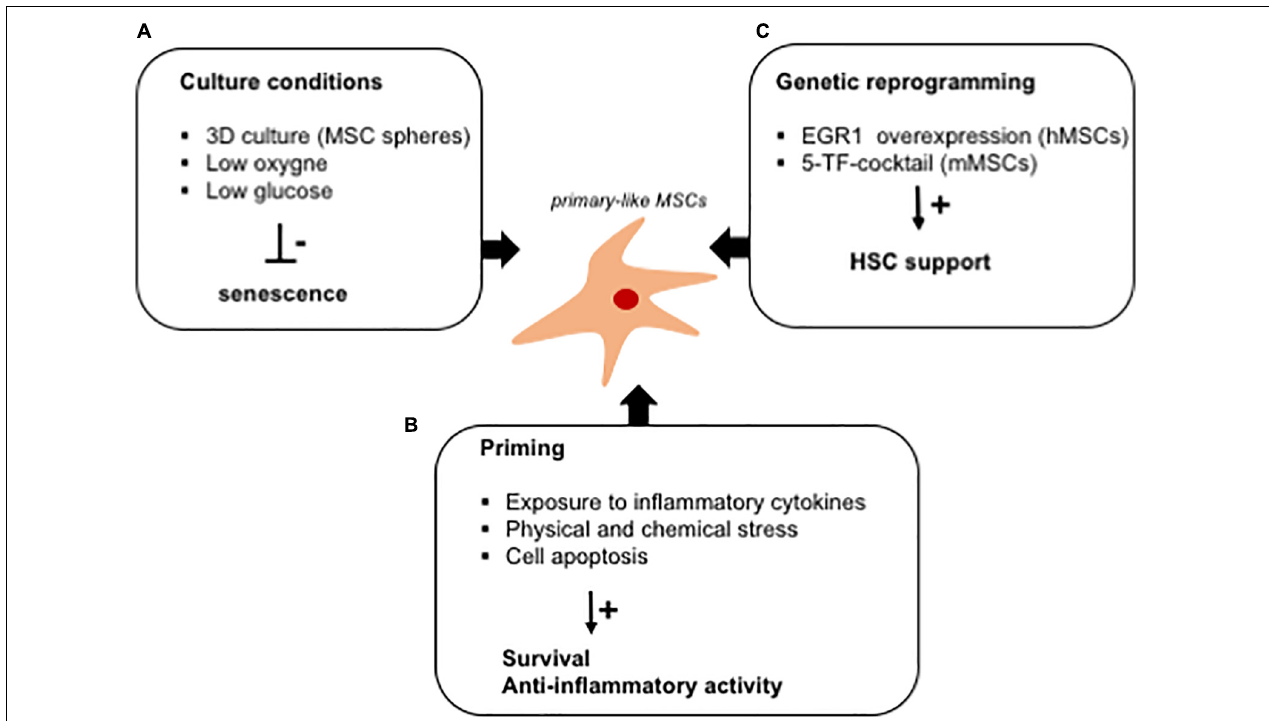
FIGURE 3 | In vitro strategies to fully exploit the hematopoietic supportive capacity of ex vivo expanded MSCs. Schematic representation of culture strategies aimed at improving the hematopoietic supportive capacity of MSCs, which is impaired upon ex vivo expansion. (A) Several strategies (mesensphere, low oxygen, and low glucose cultures) have been developed to avoid the activation of a senescence program altering the secretory phenotype of ex vivo expanded MSCs. (B) MSC priming with inflammatory cytokines has been demonstrated to increase the release of anti-inflammatory cytokines by MSCs. Similarly, exposure to culture stress increases the survival rate of MSCs when transplanted in vitro . The immunomodulatory activity of MSCs has been exploited for the treatment of GVHD by inducing cell apoptosis in ex vivo expanded cells. (C) Ex vivo reprogramming by the overexpression of specific transcription factors has been studied as a strategy to render ex vivo expanded MSCs similar to primary cells, with a potentiated hematopoietic supportive